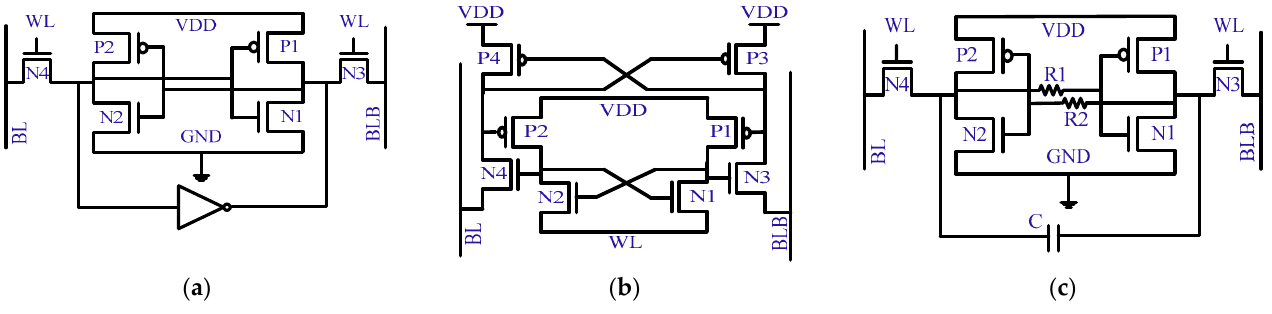
Figure 20. SRAM cell hardening for soft errors mitigation. ( a ) Increasing critical charge value [68]; ( b ) indirect connection to internal nodes [69]; ( c ) external components to slow down response